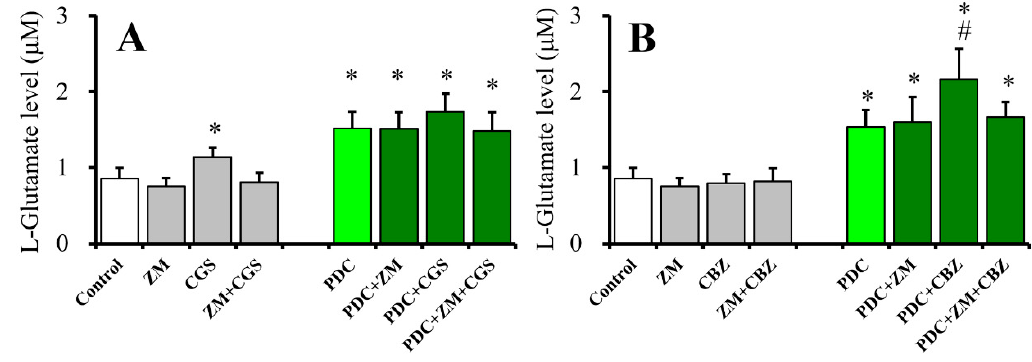
Figure 4. E ff ects of 100 nM ZM241285 (A2AR antagonist) on 100 nM CGS21680-evoked ( A ) and 20 µ M CBZ-evoked ( B ) astroglial L-glutamate releases. Acute e ff ects of A2AR antagonist (ZM: 100 nM) on 100 nM CGS21680-evoked L-glutamate release under the glutamate transporter functional